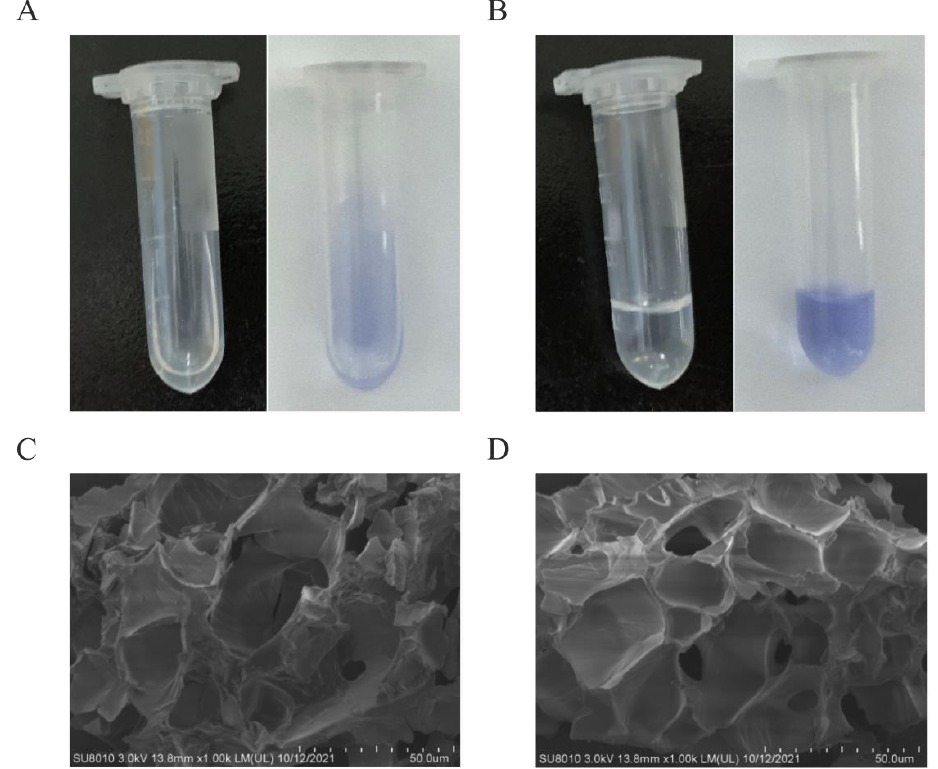
Figure 1. Images of the hydrogel solution and the LysP53 hydrogel solution containing crystal violet at ( A ) room temperature (flowable solution) and ( B ) 32 °C (rigid gel). The SEM micrographs of the Poloxamer 407 hydrogel ( C ) and LysP53-loaded Poloxamer 407 hydrogel ( D ). The addition of LysP53 does not affect the three-dimensional structure of the poloxamer 407 hydrogel. A and B are microtubes lying